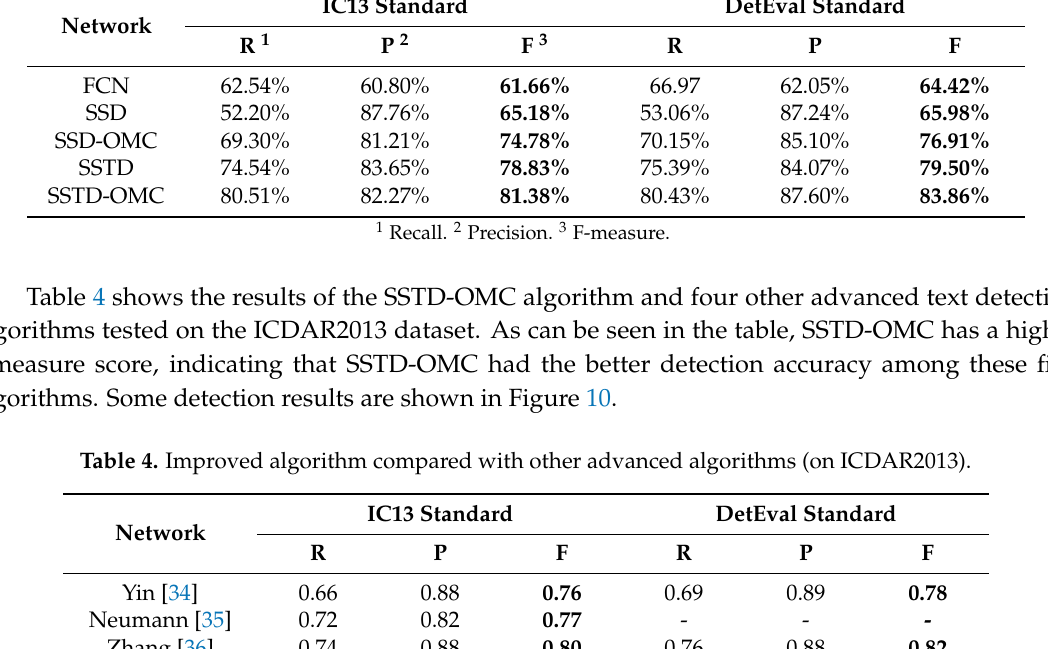
Table 3. Improved algorithm compared with original algorithm (on ICDAR2013). Network